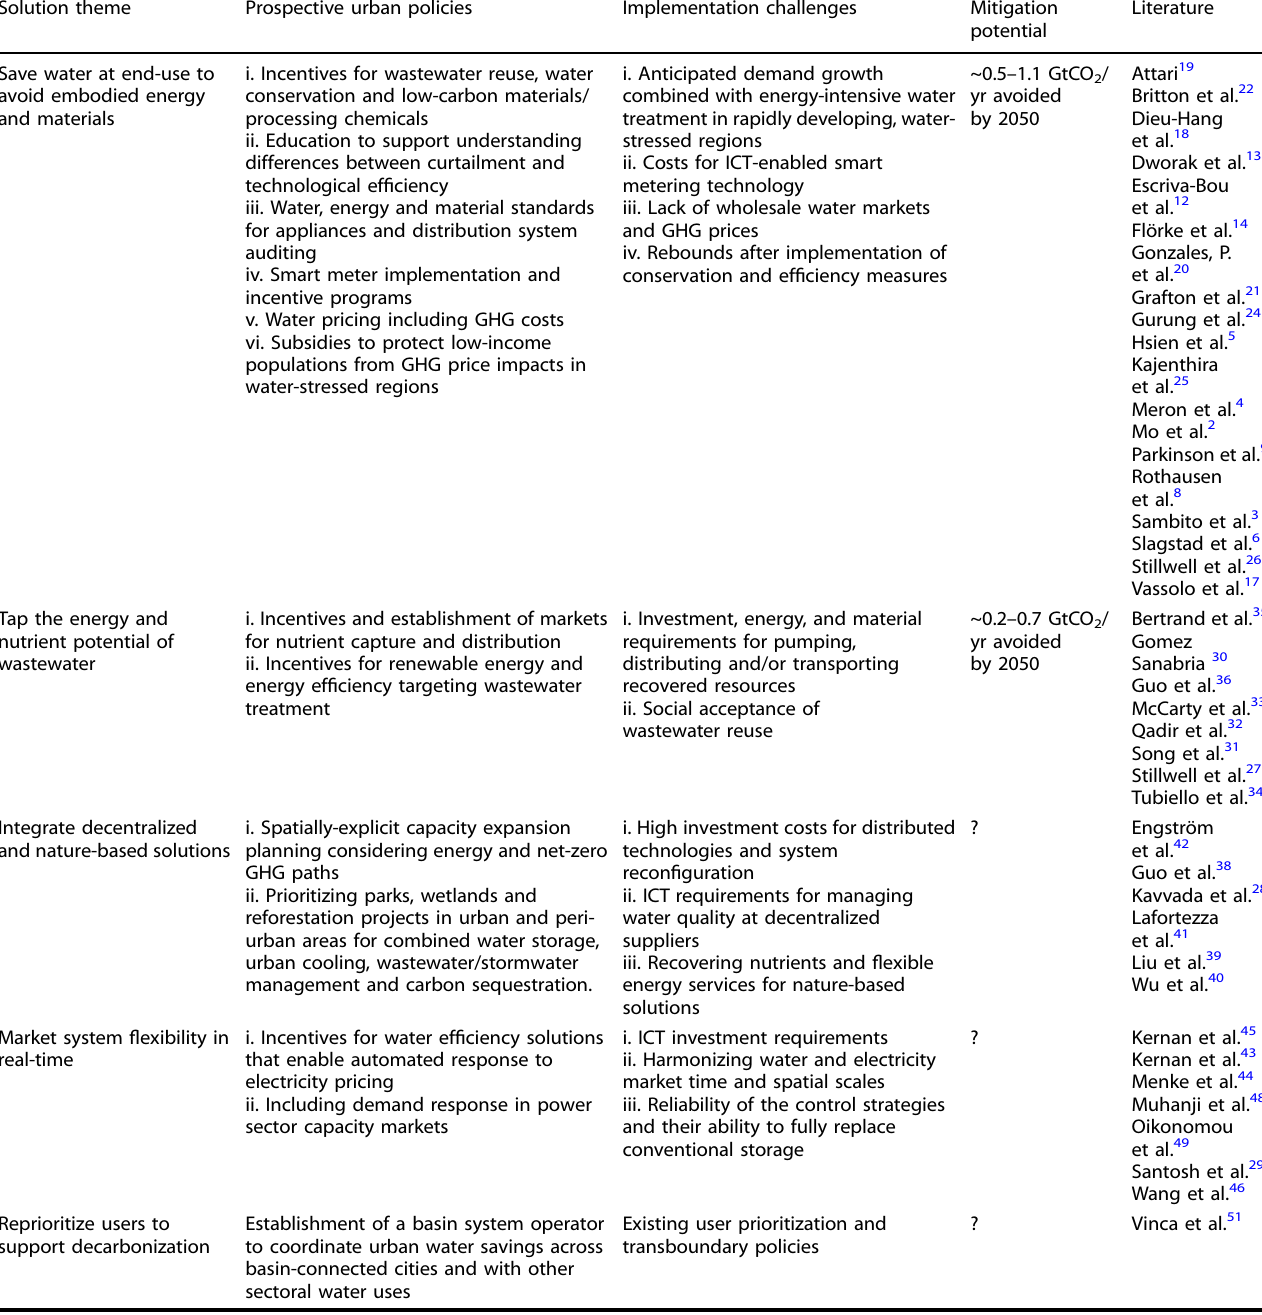
Table 1. Solution themes for guiding urban water management towards 1.5